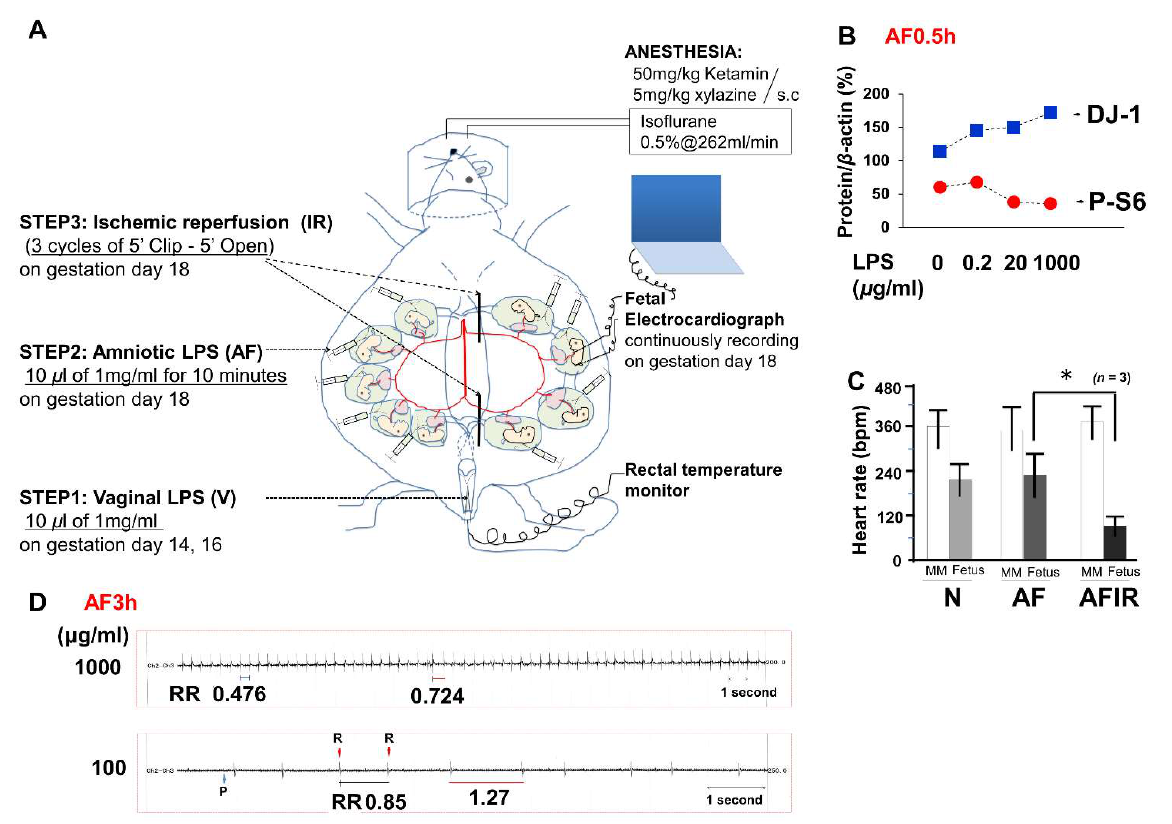
Figure 1. Fetal electrocardiography detects ischemic reperfusion. ( A ) A novel mouse model to expose fetuses to vaginal lipopolysaccharide (LPS) preconditioning, amniotic LPS, and ischemic reperfusion from gestational days (GDs) 14–18. On GD18, fetal electrocardiography (FECG) was used as a real-time monitor. ( B ) Western blot assays of amniotic fluid (AF) LPS 0.5 h fetal brain tissue lysate (1% NP40) to detect Parkinson-disease 7 (PARK7, also known as DJ)-1 under indicated LPS concentration. ( C ) Heart rate detected by FECG of indicated conditions including ischemic reperfusion after exposure to lethal amniotic LPS (AFIR). * p < 0.05. ( D ) FECG of fetuses (AF condition) exposed to amniotic LPS at both 1 mg/mL and 0.1 mg/mL concentrations.